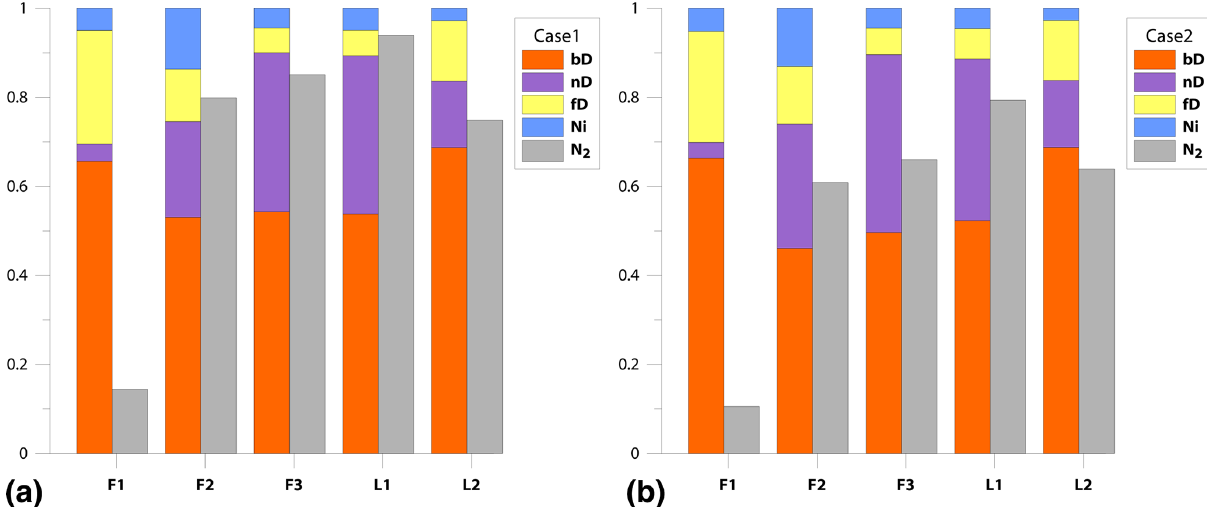
Figure 4. Bar plots showing modeled pathway fractions ( f bD , f nD , f fD , f Ni ) and N 2 flux contribution in the total (N 2 + N 2 O) flux (1 − r N Results for both modeling cases, Case 1 (a) and Case 2 (b) , are